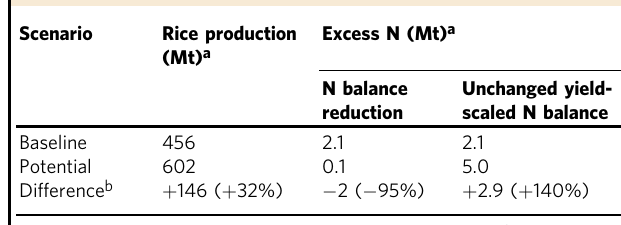
Table 1 Potential production and environmental impact of closing yield gap to 75% of yield potential in 19 cropping systems with relatively large yield gaps (i.e., average yield < 60% of yield potential) with (i) simultaneous reduction of nitrogen (N) balance to 75 kg N ha − 1 in eight cropping systems with large N balance (>100 kg N ha − 1 ) and (ii) without changes in current yield-scaled N